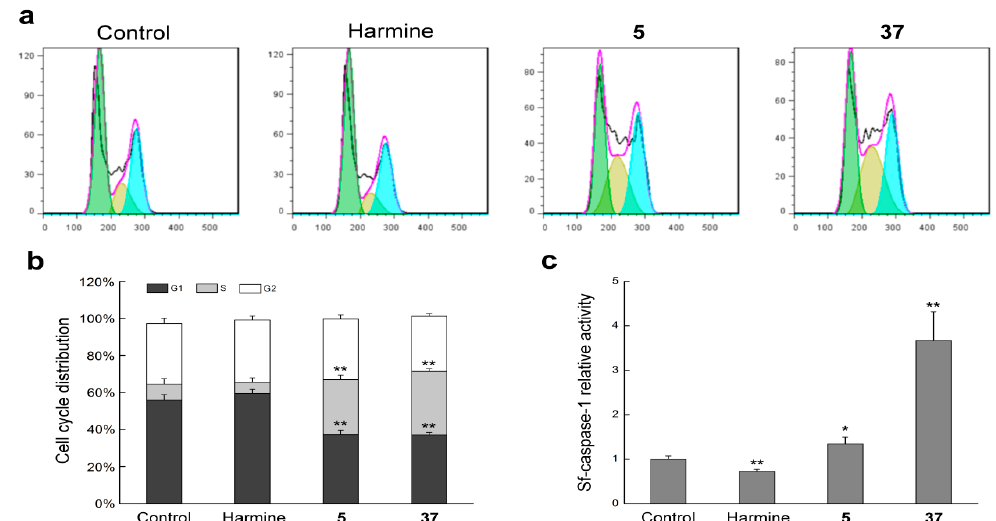
Figure 4. Compounds 5 and 37 induced cell cycle arrest and stimulated Sf-caspase-1 activation in Sf9 cells. ( a ) Cell cycle analysis by flow cytometry. Cells were treated with 12.5 μ g mL − 1 harmine, 5 and 37 for 24 h; ( b ) The percentage of cells in the G1, S and G2 phases of the cell cycle; ( c ) Sf-caspase-1 activity of Sf9 cells after treatment with 12.5 μ g mL − 1 harmine, 5 and 37 for 24 h. Note: (*) p < 0.05 and (**) p < 0.01 in comparison to the control.